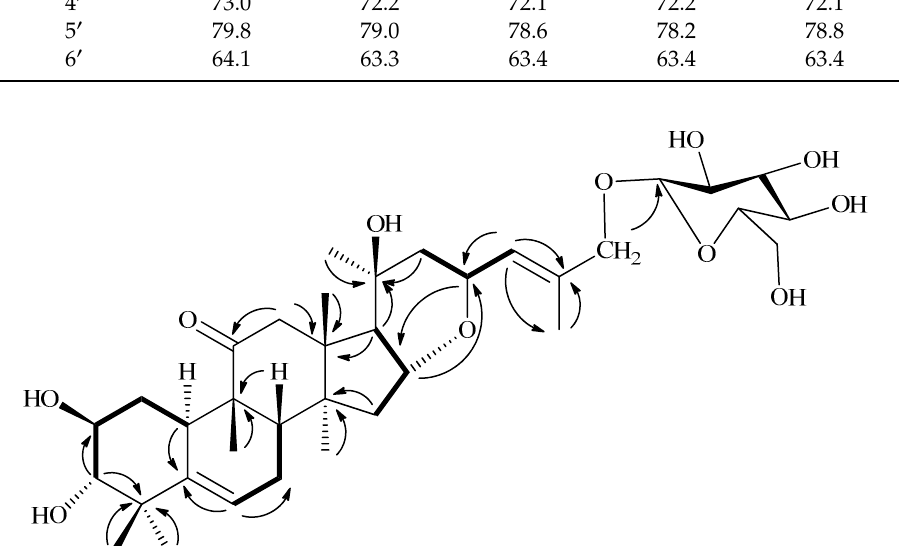
Molecules 201 9 , 2 4 , x FOR PEER REVIEW 3 of 9